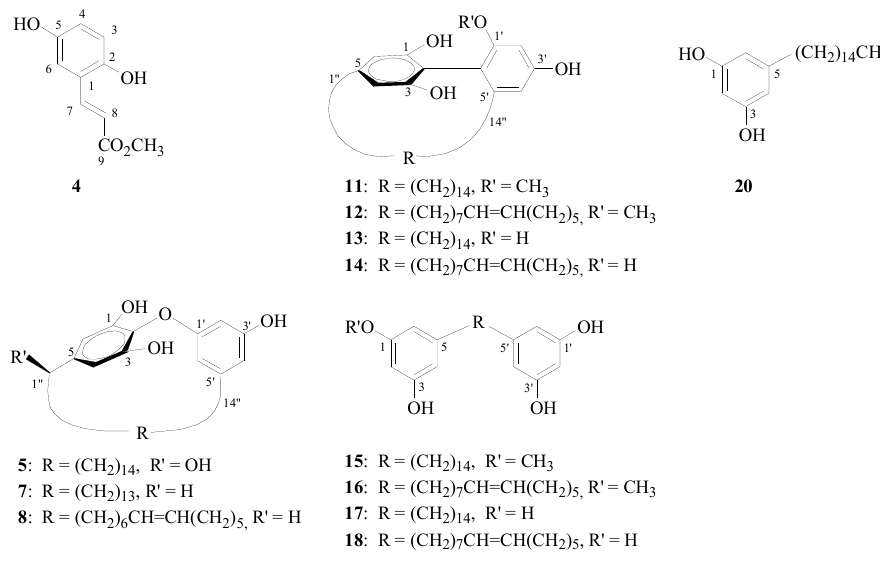
Figure 3. Structures of compounds 4 , 5 , 7 , 8 , 11–18 , and 20